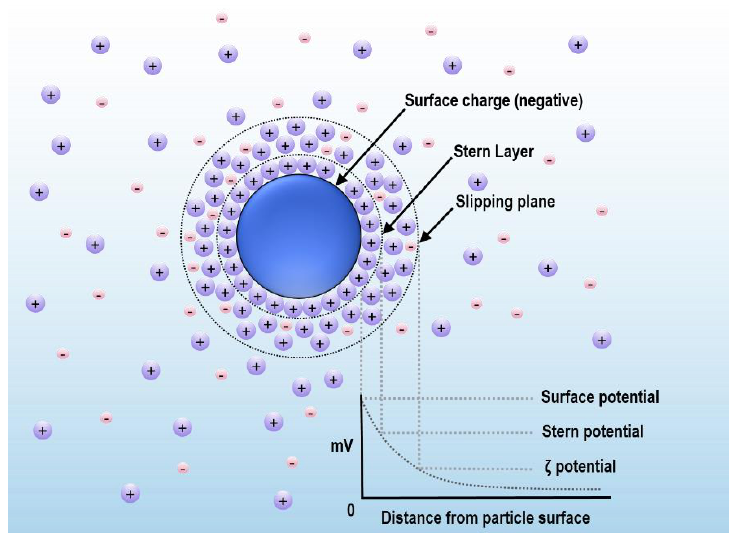
Figure 21. Schematic representation of the two layers forming the electric double layer (EDL) developed on a negatively charged particle. The inner layer, called the Stern layer, is composed by ions of charge opposed to the particle surface, i.e., positive ions in this case. The outer layer, also known as diffuse layer, is made up of both negative and positive charges. The Zeta Potential is the electrokinetic potential at the slipping plane.